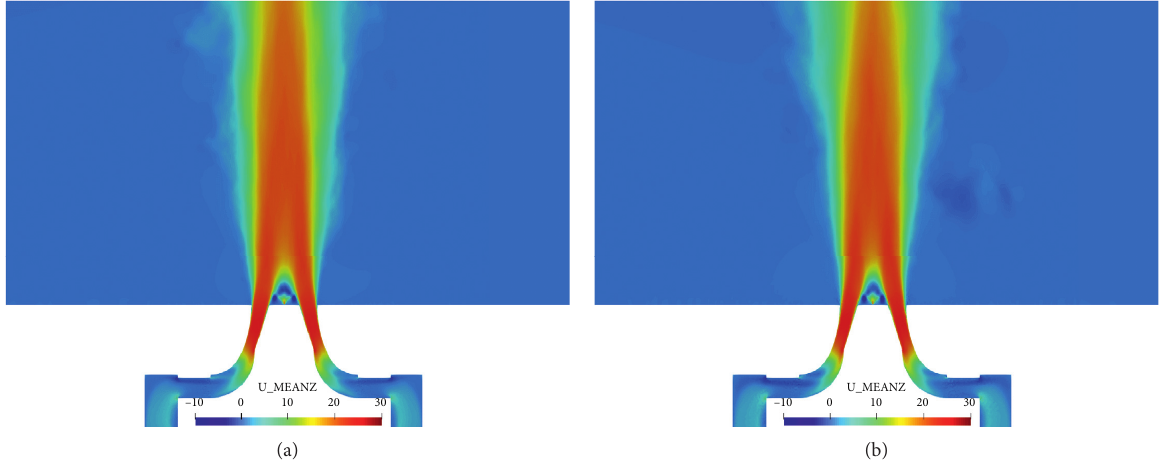
Figure 7: Mean axial velocity fields for cases A-NR (a) and B-NR (b) in the central vertical plane.